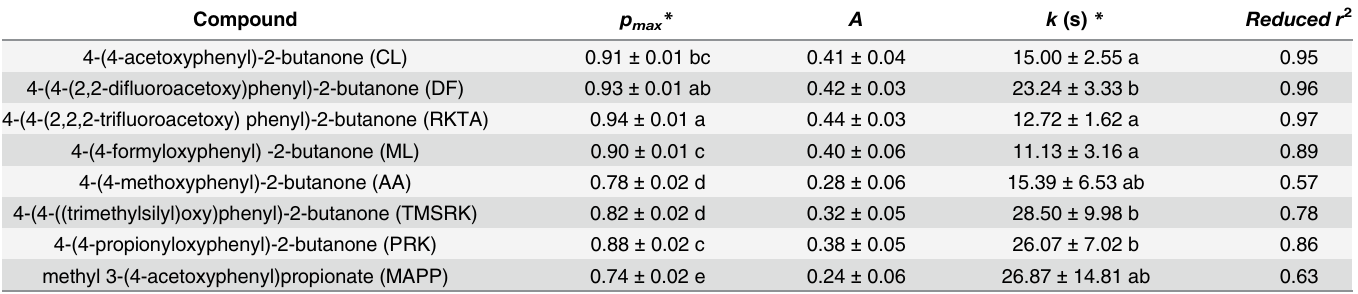
Table 4. Exponential Growth Curve Parameters for Fitting Response Probability ( p max ± 95% confidence interval (CI)) of Q-fly Males in Bioassays to the Function.